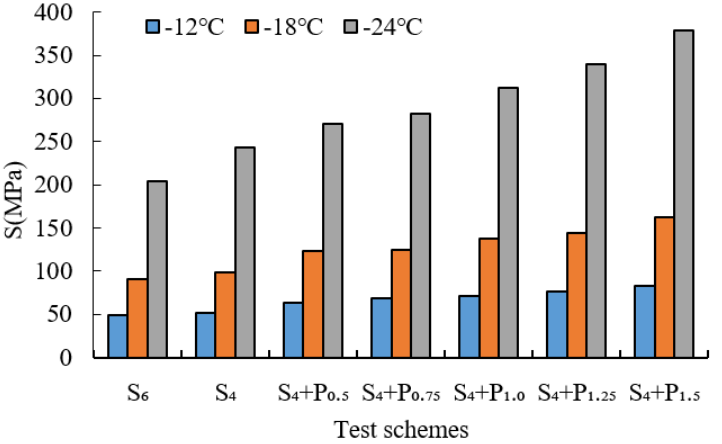
Figure 11. Creep stiffness of PPA – SBS and LH – 90# asphalt.